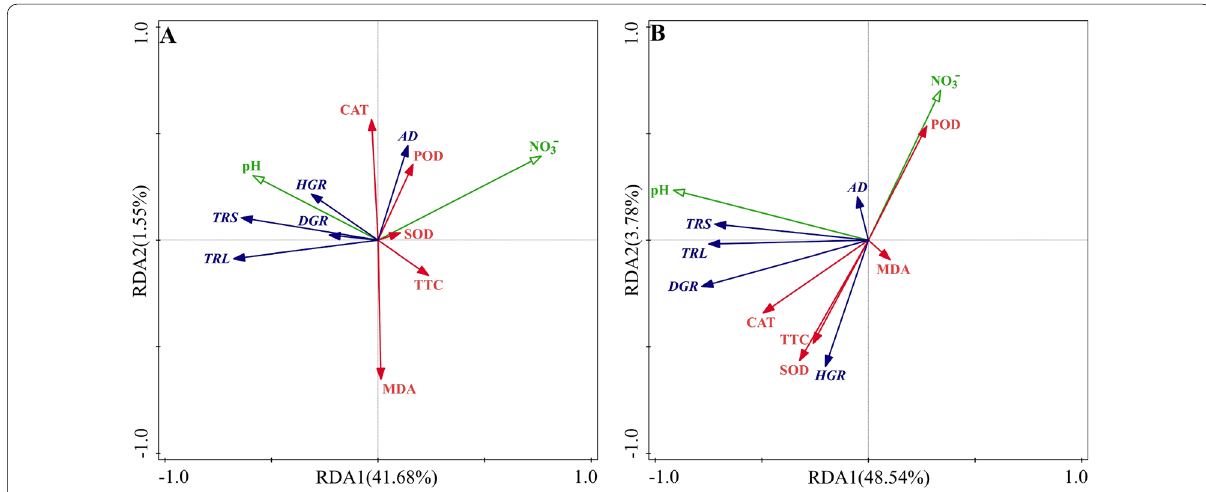
Fig. 6 Redundant analysis of simulated AR, growth rates, root morphologies, and root physiological properties. The angles and lengths of the arrows indicate the direction and strength of the relationship of simulated AR, growth rates, root morphologies, and root physiological properties. A Redundant analysis of Q. acutissima ; B redundant analysis of C. lanceolata . RDA, redundant analysis; pH, AR pH; NO 3 − , the concentration of NO 3 − in AR; HGR, height growth rate; DGR, basal diameter growth rate; TRL, total root length; TRS, total root surface area; AD, root average diameter; MDA, root malondialdehyde content; TTC, root activity; SOD, superoxide dismutase activity in root; POD, peroxidase activity in root; CAT, catalase activity in root